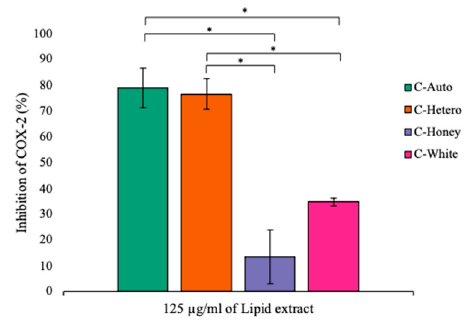
Figure 7. Anti-inflammatory potential (COX-2 assay) of lipid extracts from C-Auto, C-Hetero, C- Honey, and C-White. The results are expressed as a percentage of COX-2 inhibition as a function of the concentration of lipid extracts (125 µg mL − 1 ). Data represented as means ± SD, n = 3. * q < 0.05. At the concentration of 125 µg mL − 1 of lipid extract, C-Auto showed the highest in- hibitory potential of COX-2 activity (79.1 ± 7.7%), followed by C-Hetero (76.8 ± 5.9%), C-